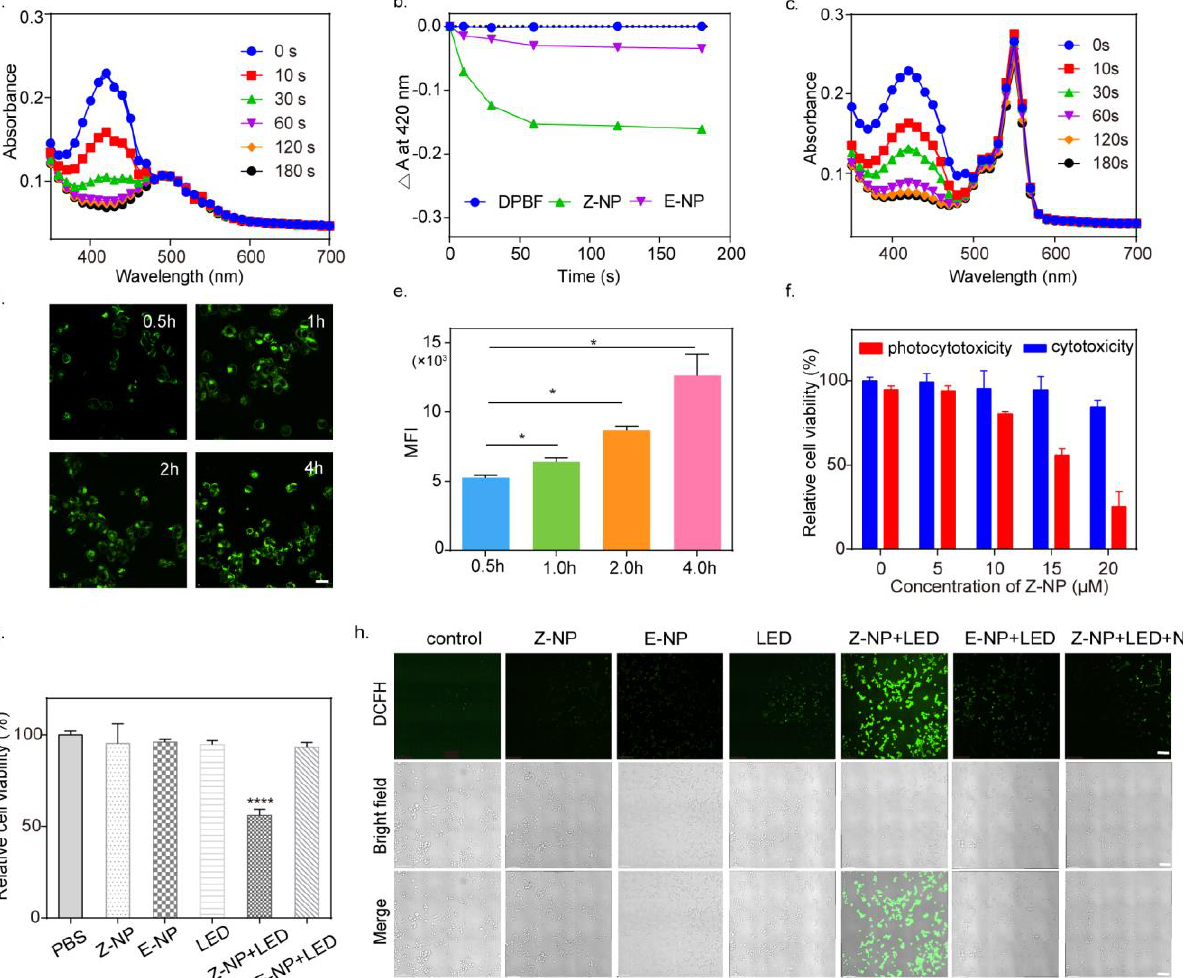
Figure 3. In vitro evaluation of 6Br-HTI-TPA-OMe NPs for reversible control 1 O 2 generation. ( a ) Absorption spectrum of DPBF (30 µ M) with Z-NP (Z isomer concentration: 10 µ M) in water at different irradiations. ( b ) Photodegradation rate of DPBF with or without different nano photosensitizers. ( c ) Absorption spectrum of DPBF (30 µ M) with RB (10 µ M) in water at different irradiations. Real-time uptake images ( d ) and flow cytometry MFI value ( e ) of Z-NPs (15 µ M) in 4T1 cells at different time points (0.5 h, 1 h, 2 h, 4 h). ( f ) MTS assay of Z-NPs at various concentrations co-cultured with 4T1 cells with or without LED irradiation (LED: 520 nm, 40 mW/cm 2 , 5 min). ( g ) MTS assay of 4T1 cells incubated with different treatments. ( h ) Confocal images of 4T1 cells stained with DCFH-DA after different treatments. The treatments included PBS, Z-NPs, E-NPs, LED, Z-NP+LED, E-NP+LED, Z-NP+LED+NaN 3 (Z isomer concentration: 15 μM, NaN 3 concentration: 20 mM, 520 nm, 40 mW/cm 2 , 5 min, scale bar: 100 μm). Significant differences between the groups were labelled for * p < 0.05, and **** for p < 0.0001.